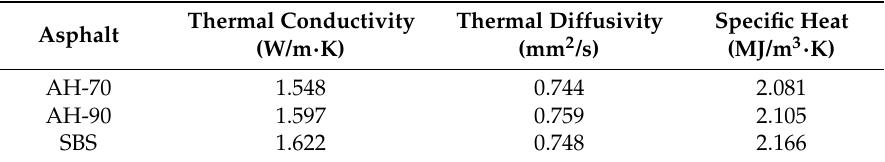
Table 4. Thermal properties of asphalt mixtures prepared by different asphalt